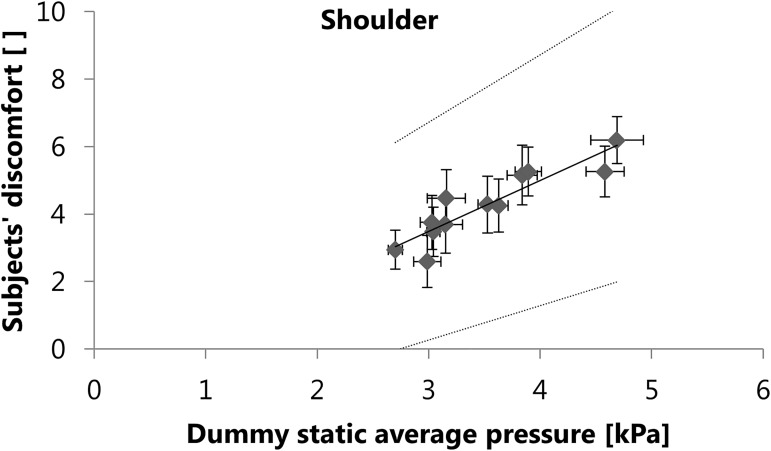
Results of the regression analysis using the pressure parameters measured on the dummy as independent variables.Static average pressure measured on the dummy is a significant (p<0.001) predictor of the subjects’ discomfort in the shoulder region. The subject’s discomfort was rated on a visual analogue scale, ranging from 0 = no discomfort to 10 = maximal discomfort. The non-significant predictors were removed from the model during the backwards elimination of the regression analysis. Data points show the mean ± standard error of measurement for each configuration, dotted lines show 95% prediction intervals. Regression equation: y = 1.512x - 1.044, R2 = 0.82.